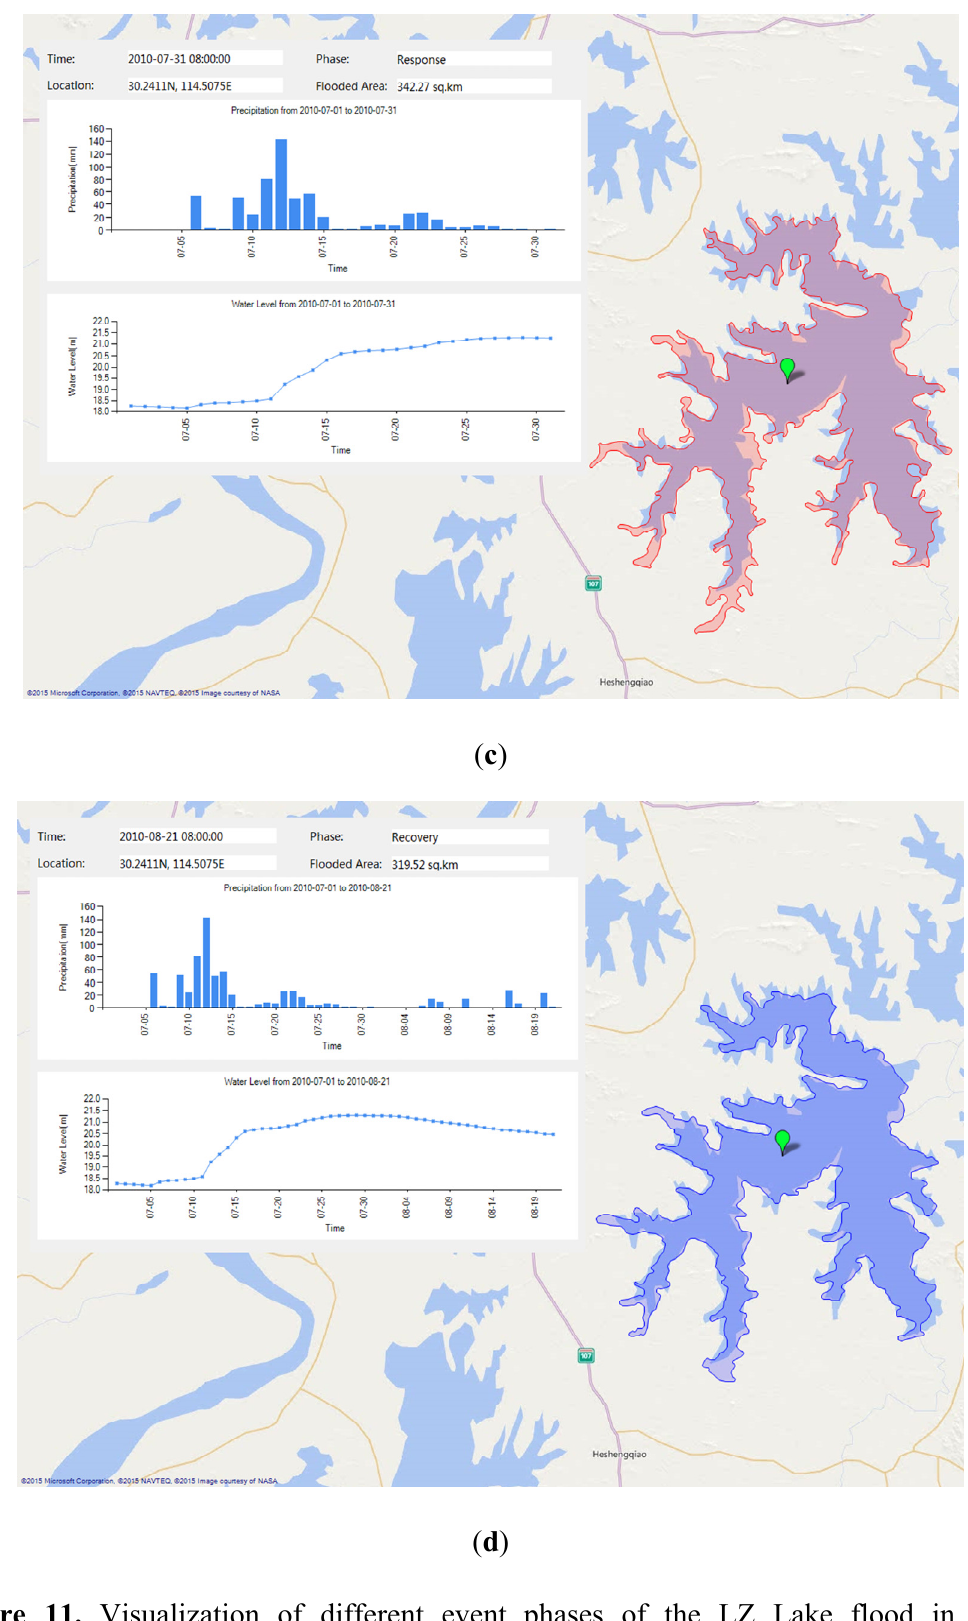
Figure 11. Visualization of different event phases of the LZ Lake flood in 2010. ( a ) Diagnosis visualization; ( b ) Preparedness visualization; ( c ) Response visualization; ( d ) Recovery